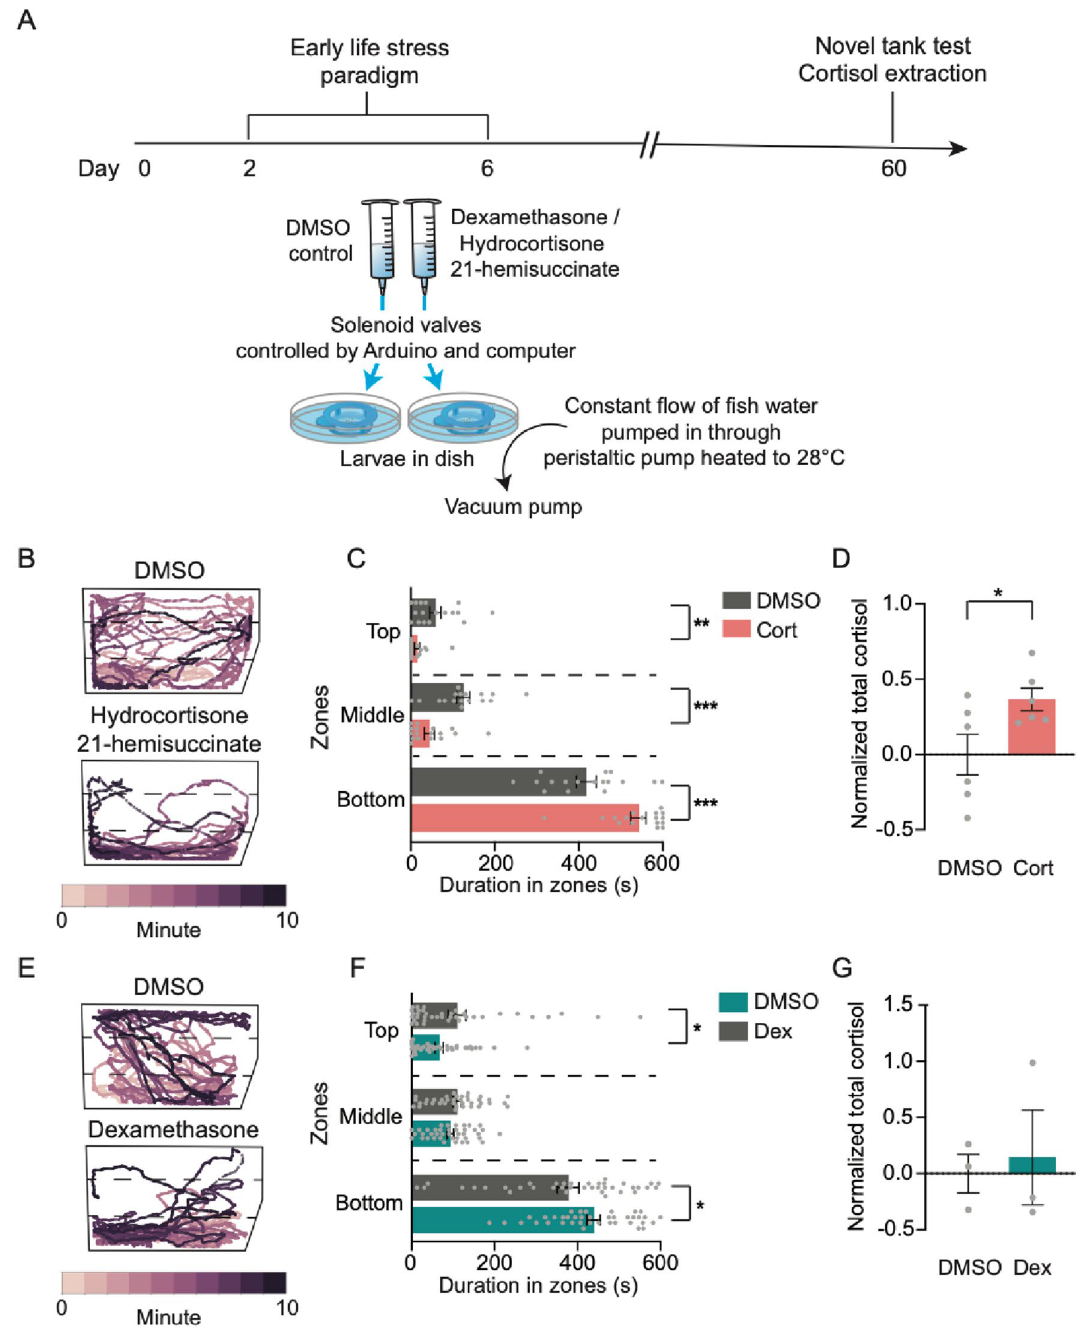
Figure 3. Treatment with corticosteroid receptor agonists in early life induces adulthood anxiety. ( A ) Timeline of drug-treated ELS and experiments conducted. A schematic diagram of the setup is presented below the timeline. ( B ) Representative swim paths of 60 dpf controls (DMSO) and hydrocortisone 21-hemisuccinate- (Cort) treated animals. Drug-treated individuals tend to spend more time at the bottom of the tank. ( C ) Total duration spent in the bottom zone of the novel tank was significantly increased in Cort animals (Unpaired t test, p = 0.0001), and decreased in the top (Unpaired t test, p = 0.0026) and middle (Unpaired t test, p = 0.0002) zones, compared to control DMSO. N = 17 per group. ( D ) Basal cortisol levels were significantly higher in Cort animals than control DMSO siblings (n = 6 per group, Unpaired t test, p = 0.038). ( E ) Representative swim paths of 60 dpf controls (DMSO) and dexamethasone- (Dex) treated animals. Drugtreated individuals tend to spend more time at the bottom of the tank. ( F ) Quantification of durations spent in top, middle, and bottom zones of the novel tank test revealed that Dex animals spent more time in the bottom zones (Unpaired t test, p = 0.025), and less time in the top (p = 0.035) than control DMSO animals yet no difference was observed in time spent in the middle (Unpaired t test, p = 0.11). DMSO: n = 38; Dex: n = 40. ( G ) Measurements of basal cortisol levels were no different between Dex and DMSO animals (n = 3 per group, Unpaired t test, p = 0.77). Error bars show ± standard error of the mean. Asterisks denote statistical significance (*p = 0.05, **p = 0.005, ***p = 0.0005). ns denotes no